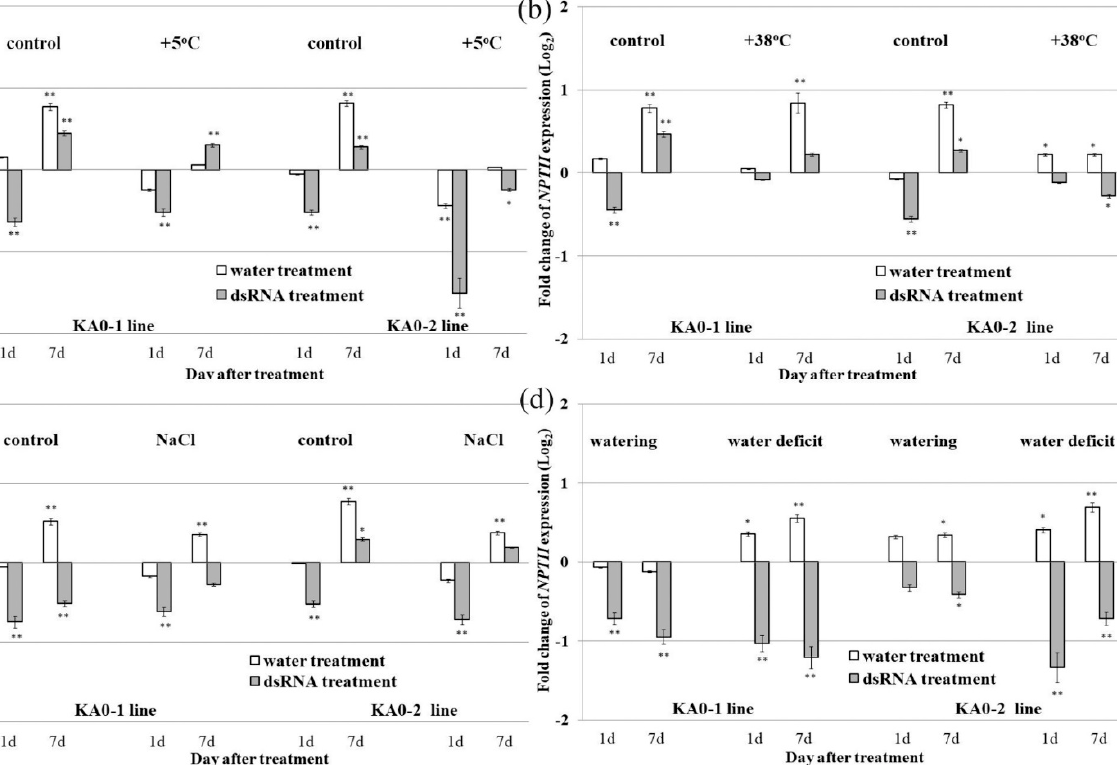
Figure 4. The effect of salt, heat, cold, and soil drying on the dsRNA-induced NPTII suppression in 4-week-old lines of Arabidopsis thaliana . Quantification the NPTII mRNA levels (log2) in the KA0-1 ( a ) and KA0-2 ( b ) lines of A. thaliana in response to foliar application of sterile filtered water (water treatment) or NPTII -encoding dsRNA (dsRNA treatment) relative to NPTII mRNA level in the same plants before treatments cultivated under different stress conditions. ( a ) For cold stress, the plants were stressed at +5 °C for 2 h after the dsRNA treatment; ( b ) for heat stress, the plants were stressed at +38 °C for 2 h after the dsRNA treatment; ( c ) for salt stress, the plants were well-irrigated with 200 mM NaCl solution for 2 h after dsRNA treatment; ( d ) for assaying the importance of soil moisture, the plants were not watered for 3 weeks or well-watered 1 d before the dsRNA treatments. For control conditions (control), the plants were normally cultivated at 22 °C. The abaxial and adaxial surface of the leaves was treated by sterile soft brushes with 0.35 µg/µL of NPTII -dsRNA or water (100 µL per individual plant). RNA was isolated from the same individual plant before, 1 day, and 7 days after treatments (two independent experiments). qRT-PCR data are presented as mean ± SE. *, **—significantly different from the untreated plant at p ≤ 0.05 and 0.01, respectively, according to the Student’s t -test.